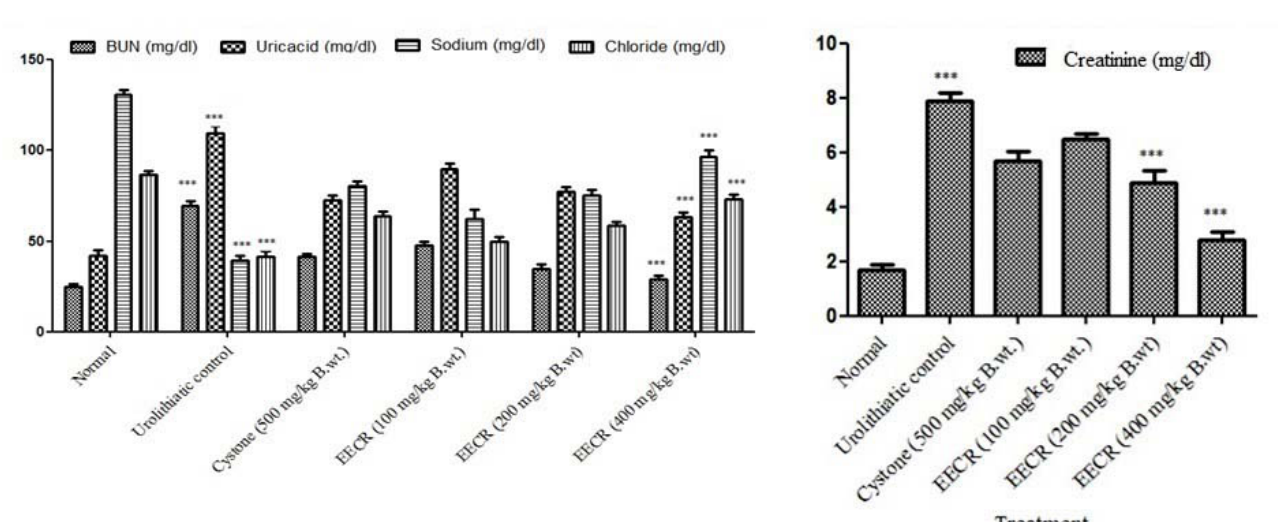
FIGURE 5 - Effect of EECR on urine BUN, uric acid, sodium and chloride in urolithiasis rats.